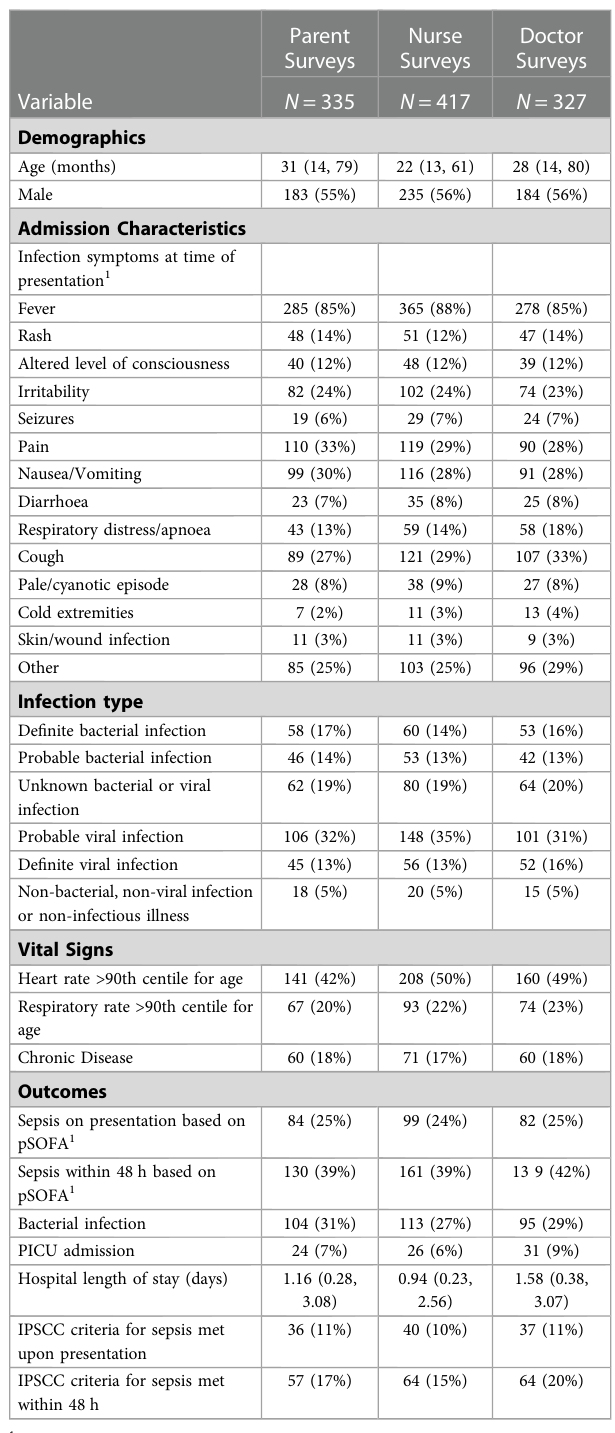
TABLE 1 Baseline characteristics and outcomes are shown for children enrolled the study cohort, according to whether surveys were obtained from parents, nurses, or doctors, respectively. The table shows counts and percentages for categorical variables and median and interquartile ranges for continuous variables. Participants are represented in multiple columns if more than one type of survey (i.e., parents, nurses, or doctors) was obtained. Only one of each survey type per patient was